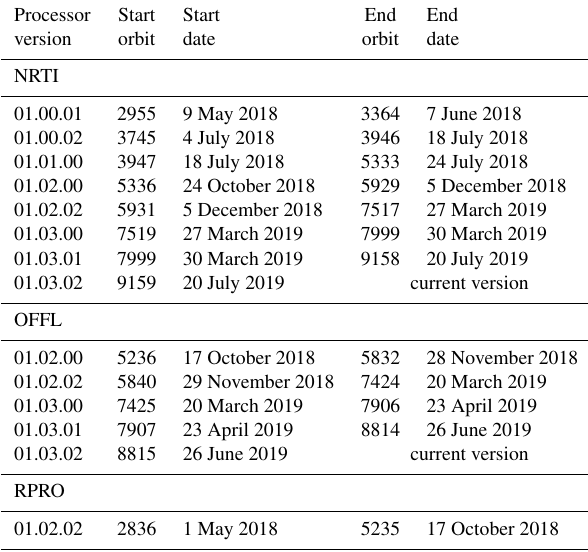
Table 1. Identification of the S5P NO 2 data versions validated here: near-real-time channel (NRTI), offline channel (OFFL), and interim reprocessing (RPRO). Major updates were those leading to v01.02.00 and to